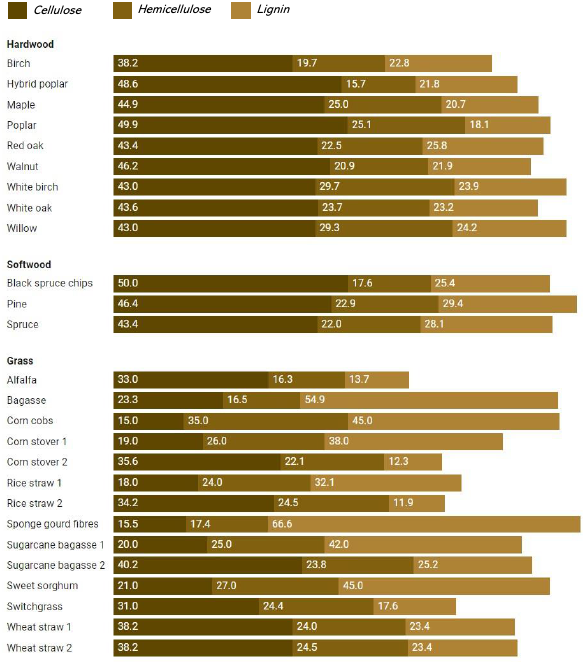
Figure 2. Composition of some lignocellulosic biomass. Table 1. Lignocellulosic biomass composition before and after extrusion.